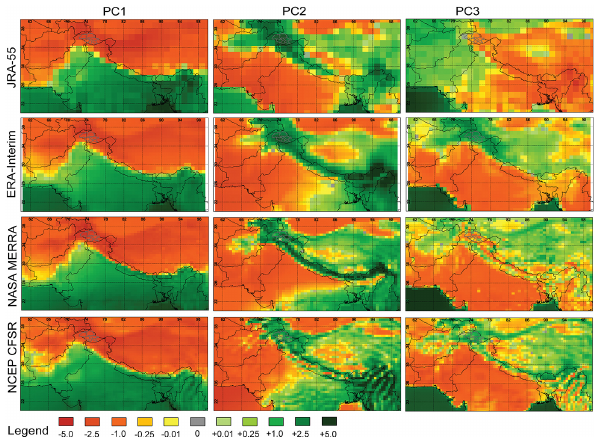
Figure 4. Comparison of the first three principal components (PCs) from each of the reanalyses used in this study. PCs are calculated from the principal component analysis (PCA) input standardised variables using the PCA output weighting factors. PCs are thus di- mensionless and values are expressed in standard